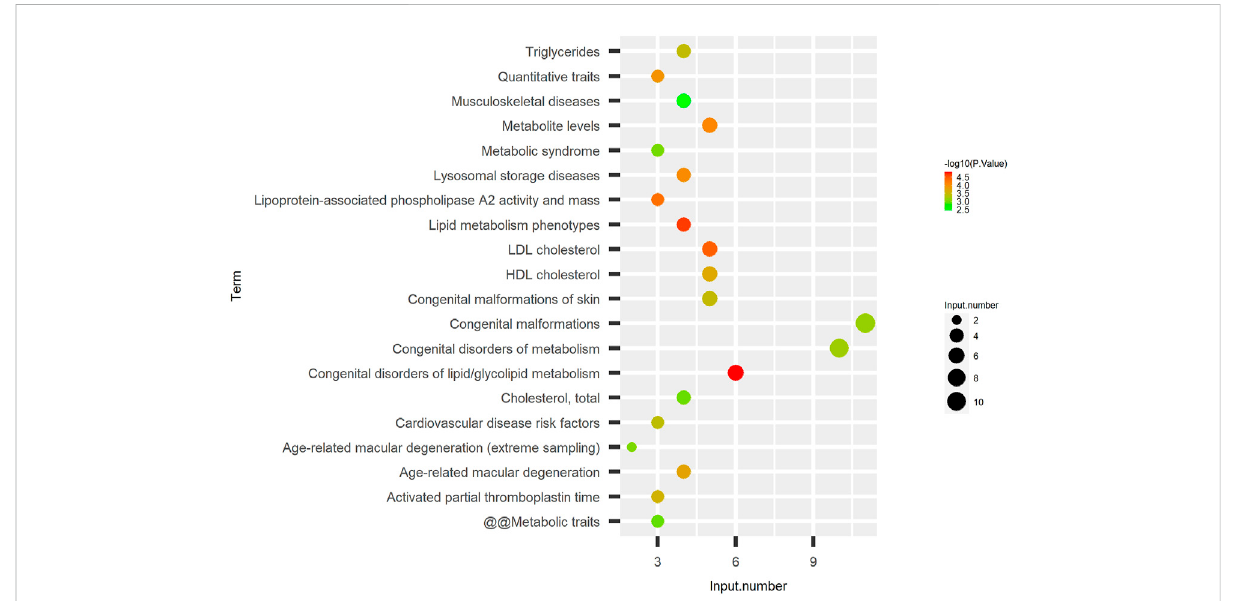
FIGURE 4 DEPs associated with lipid metabolic diseases. Disease enrichment analysis of identi fi ed DEPs. The left is the name of the disease, the right represents enrichment, and the size of the solid circle indicates the number of genes; the color of the solid circle indicates the – log10 ( p -value) of